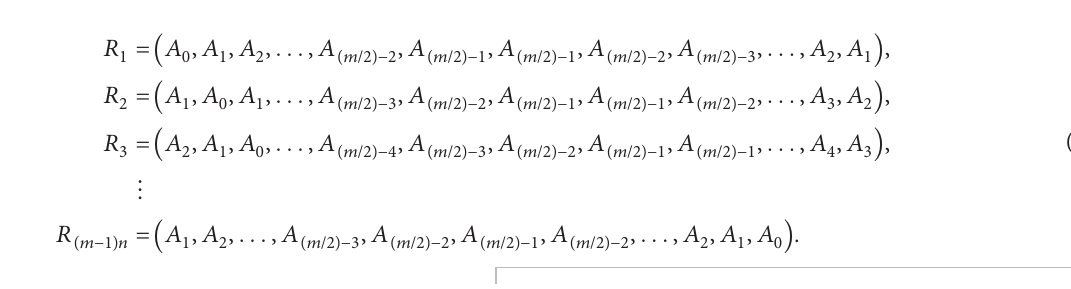
Figure 4: (a) Wiener index and (b) hyper-Wiener index for n �